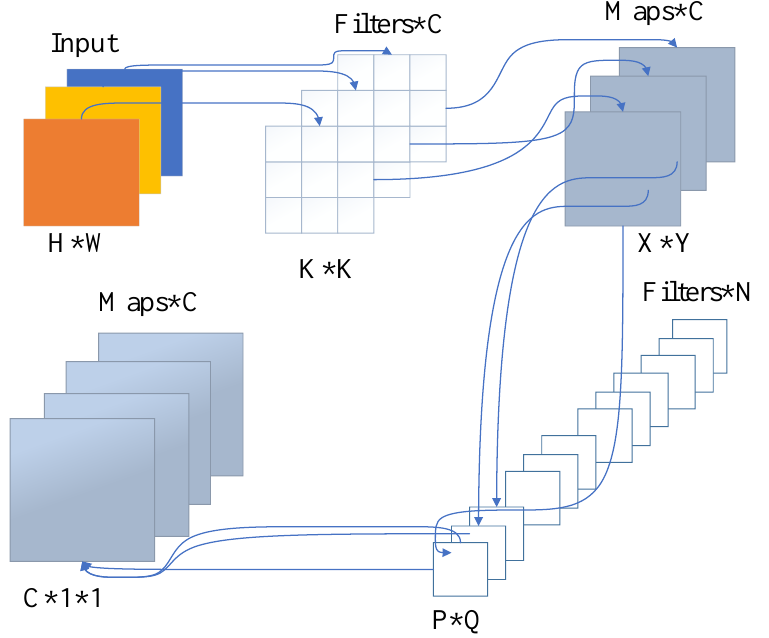
Figure 7. Deep separable convolutional neural network. (* Represents a multiple